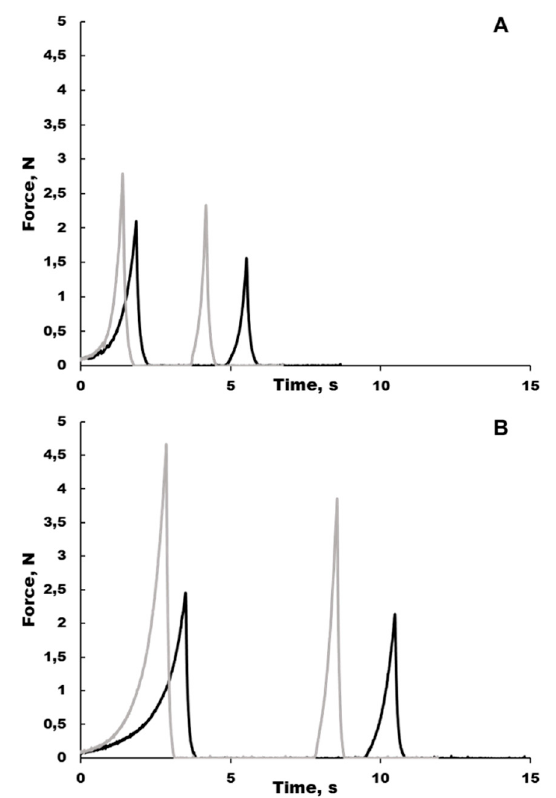
Figure 1. Texture profile curves from two representative collagen scaffolds without ( A ) and with ( B )